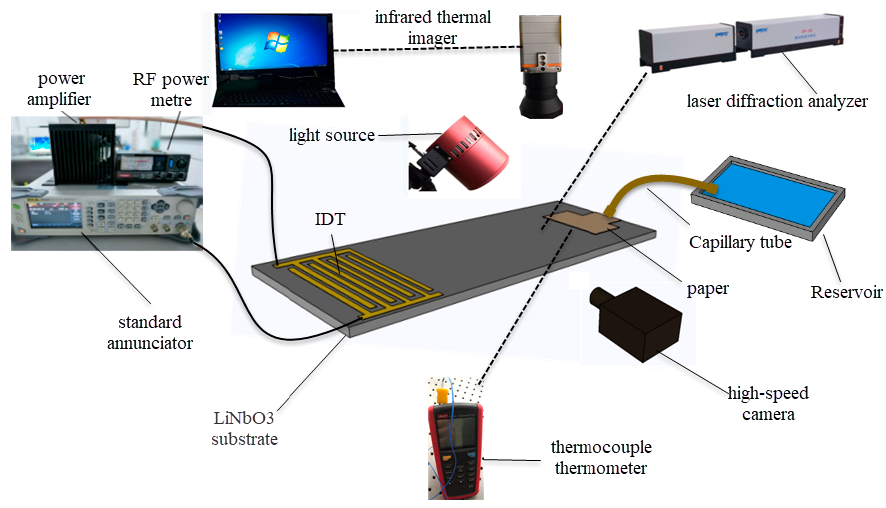
Figure 3. Experiment platform.